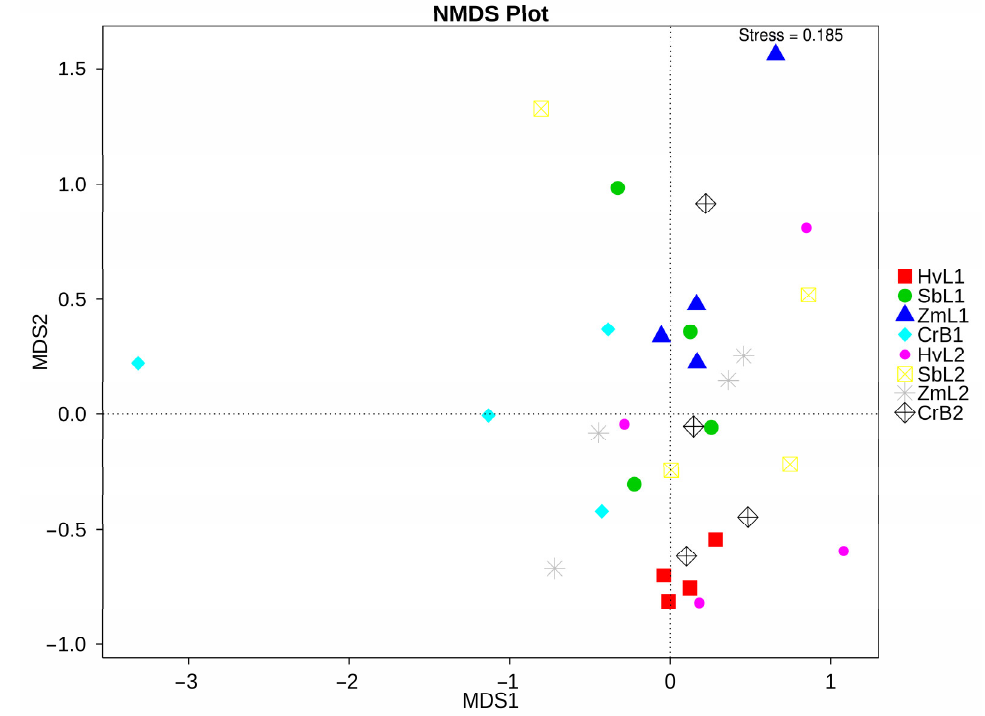
Figure 4. Nonmetric multi-dimensional scaling (NMDS) analysis of gut bacterial communities in S. frugiperda larvae fed on leaves of different host plants. Each point in the figure represents a sample; distance between points represents degree of difference, and samples in the same treatment are the same color. When stress is less than 0.2, the NMDS accurately reflects degree of difference between samples.